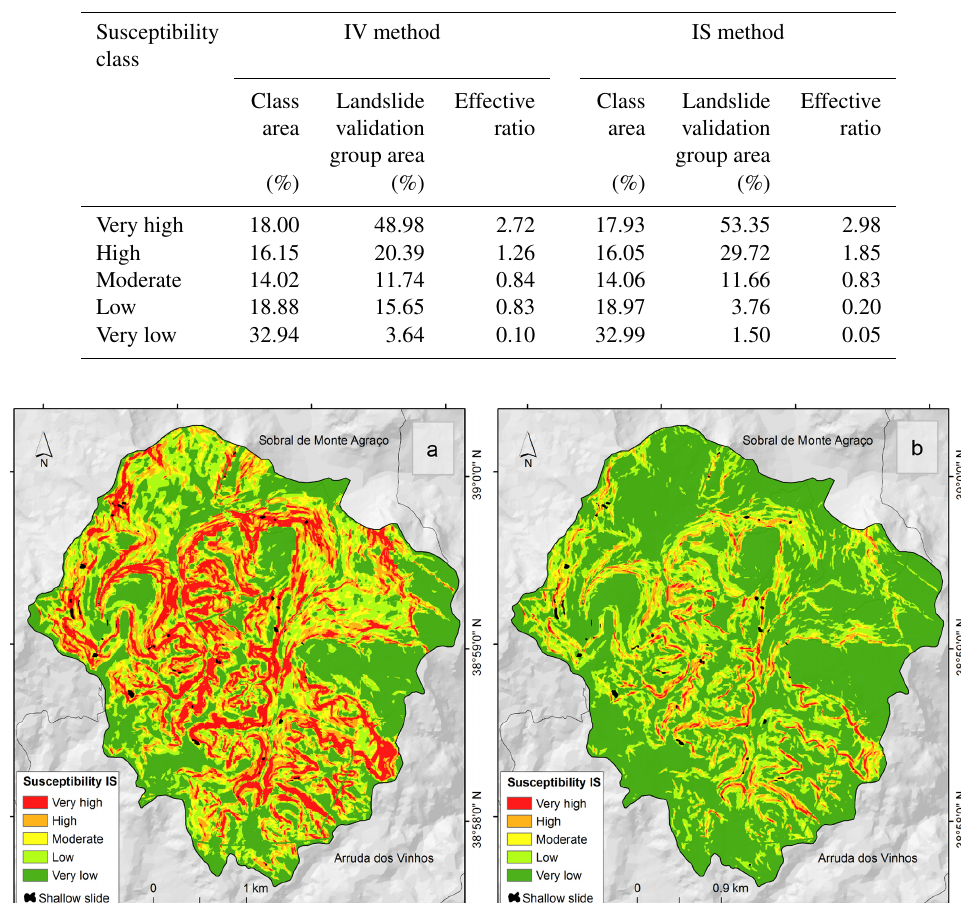
Table 5. Effective ratio of classes defined for the IV and IS shallow slide susceptibility maps.